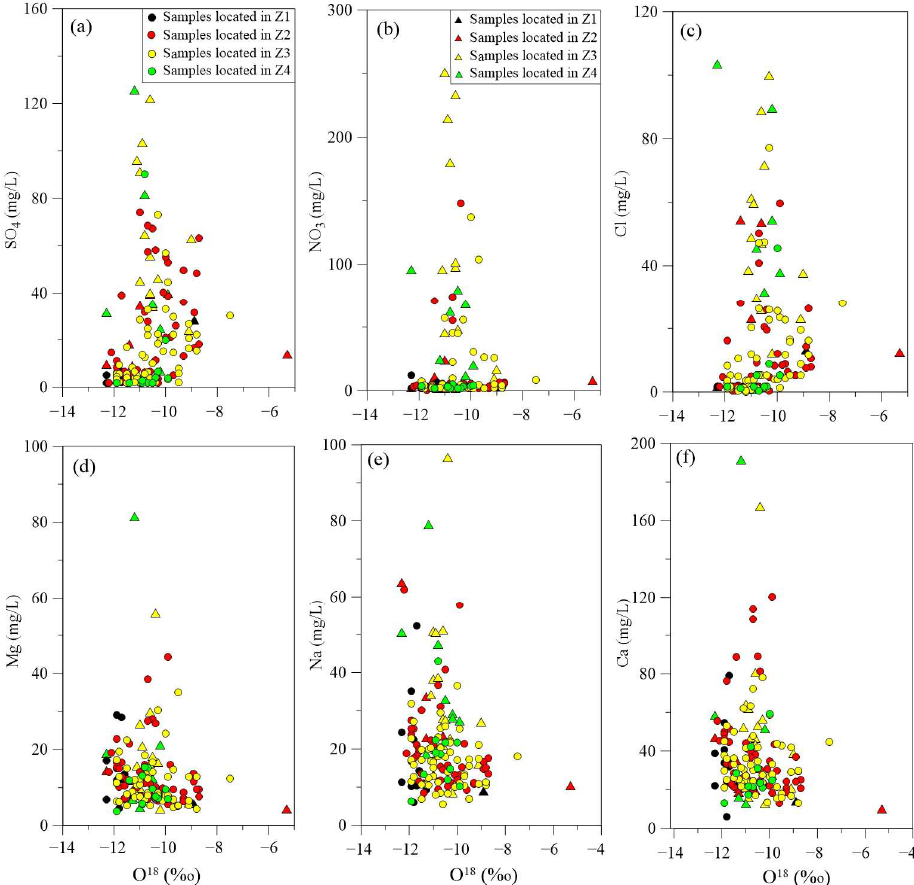
Figure 7. Variations of ( a ) SO 4 , ( b ) NO 3 , ( c ) Cl , ( d ) Mg , ( e ) Na, ( f ) Ca with the δ 18 O value of groundwater.